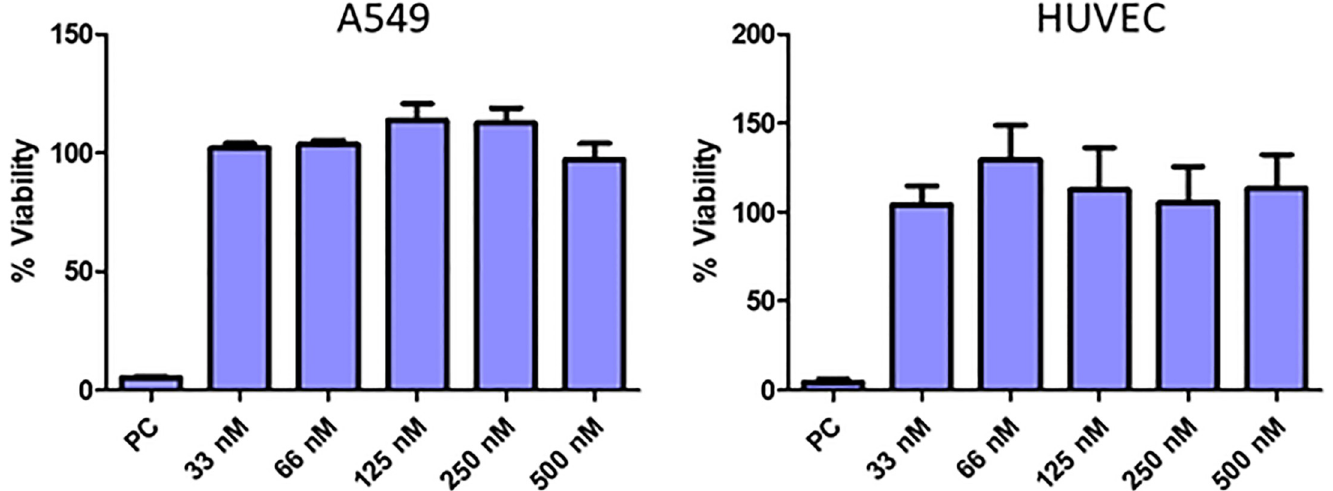
Fig 7. WST-1 assay analysis of cell viability following cNLC-TFD nanocomplex administration in A549 and HUVEC cells. Viability was assessed as percentage change against untreated negative control cells including cyclosporine positive control samples (PC). (n = 3 ± SEM).